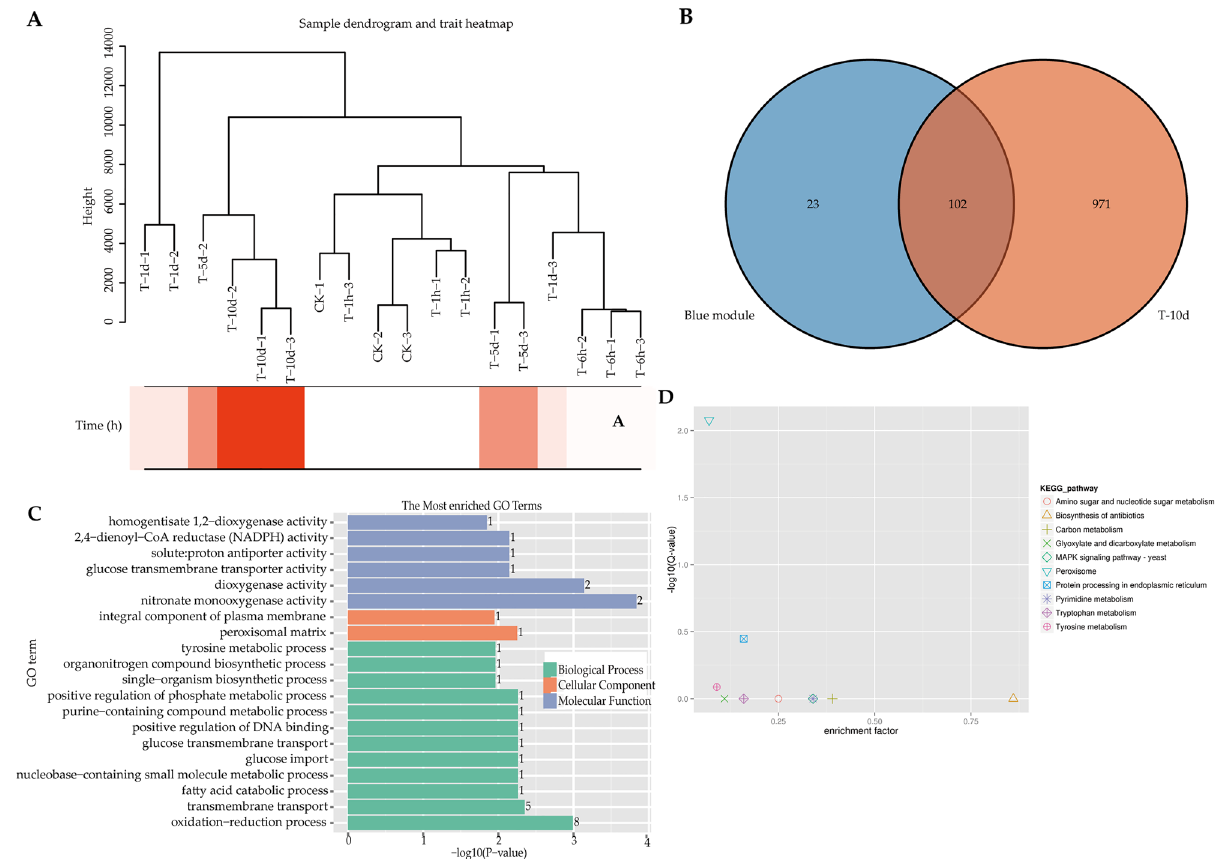
Figure 3. Function annotation of DEGs in blue module. ( A ) Sample dendrogram and trait heatmap. ( B ) The venn diagram for the blue module and DEGs in T-10d vs control group. ( C ) GO functional enrichment analysis. ( D ) KEGG pathway enrichment